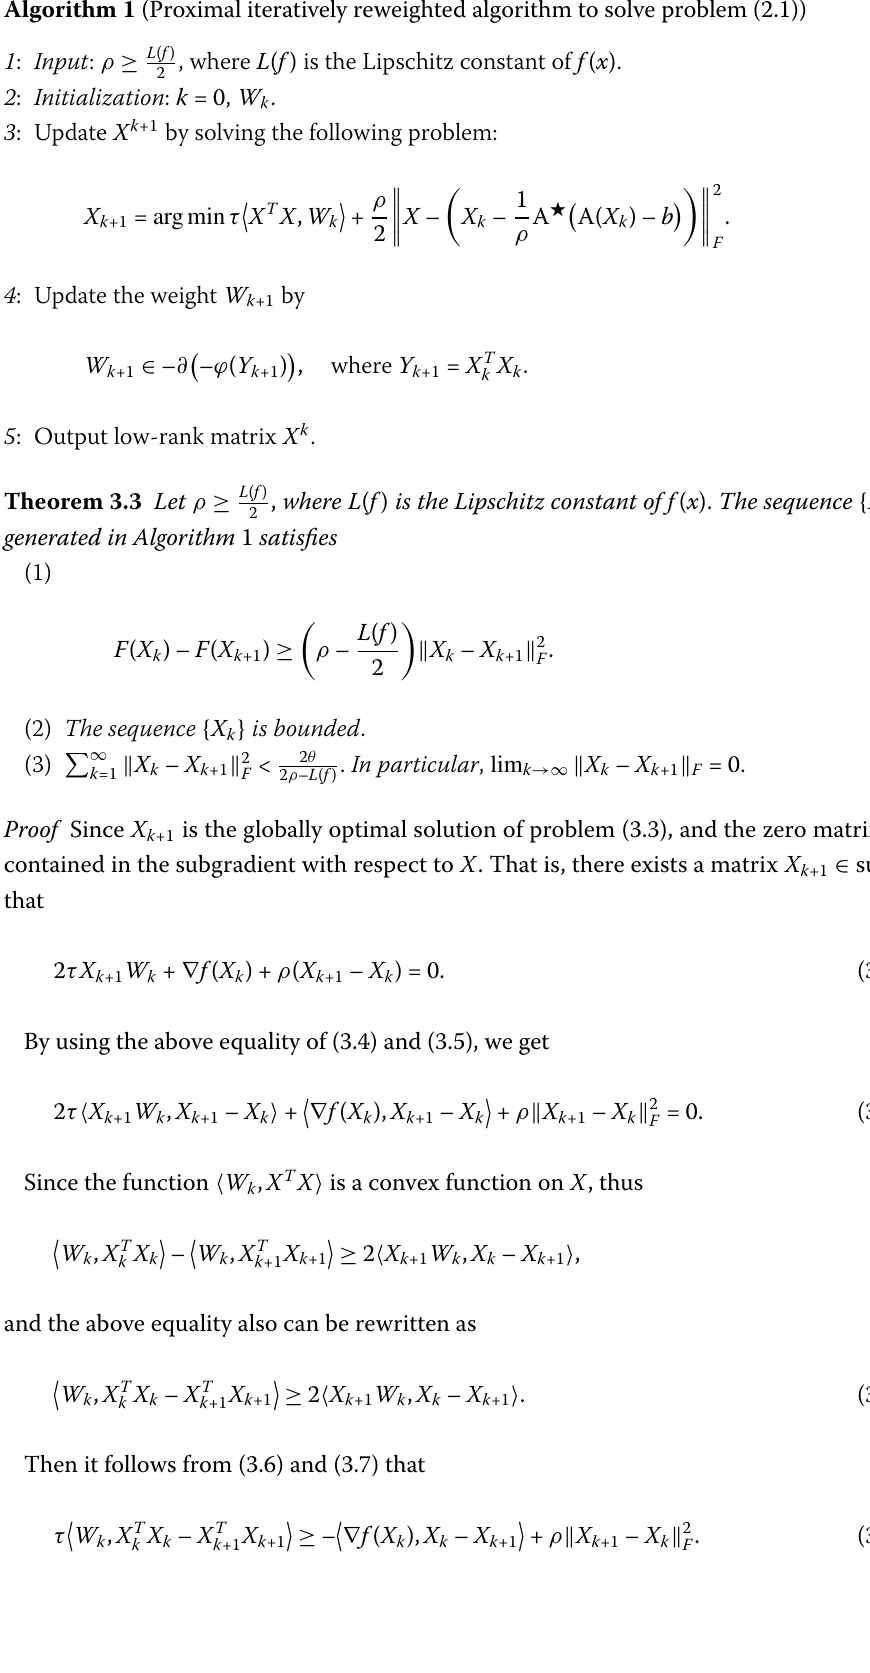
Algorithm 1 (Proximal iteratively reweighted algorithm to solve problem